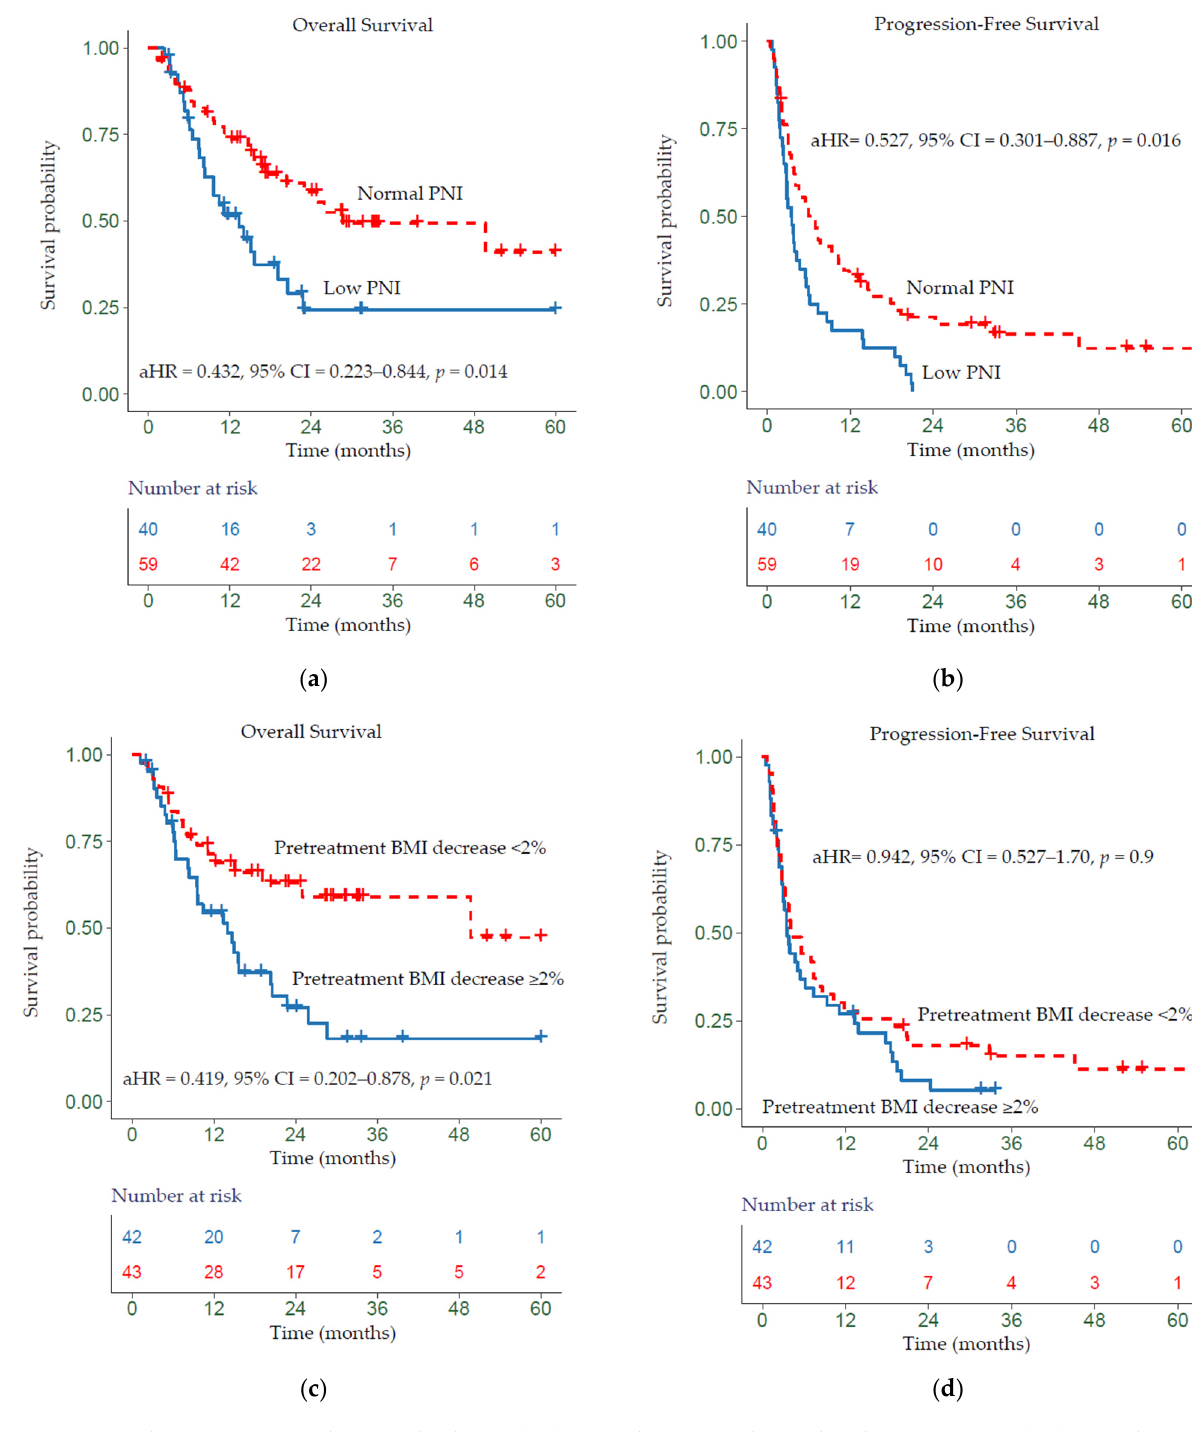
Figure 1. Kaplan–Meier survival curves displaying ( a ) and ( b ) OS and PFS according to baseline PNI group; ( c ) and ( d ) OS and PFS by pretreatment BMI trend; aHR—adjusted hazard ratio, calculated from a Cox model controlling for age, gender, HPV status, primary site, TNM, and pretreatment BMI trend or baseline PNI group. In the multivariate analysis, PNI was an independent prognostic factor for both OS